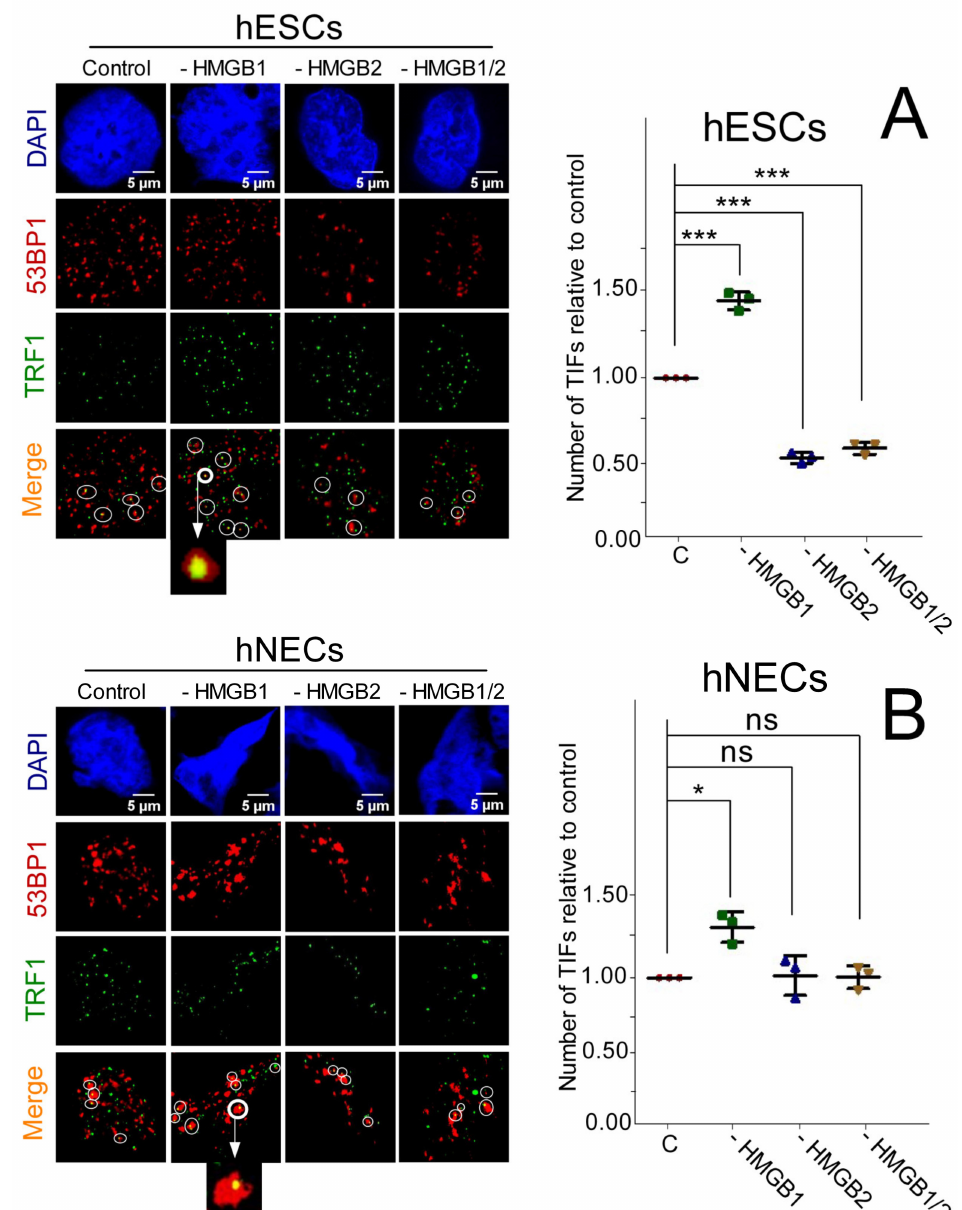
Figure 8. Accumulation of 53BP1 on telomeres in etoposide-treated cells with deregulated expression of HMGB1 / 2 . ( A ) hESCs or ( B ) hESC-derived neuroectodermal cells (hNECs) prepared according to Scenario A. Left panels: Following etoposide exposure (3.4 µ M / 3 h), control cells and HMGB1 - and / or HMGB2 -depleted cells were processed for immunofluorescence using antibodies against TRF1 (green) and 53BP1 (red) and staining of DNA (blue). Right panels: bar graphs indicate cells with ≥ 4 colocalization events of 53BP1 with telomeres (TRF1) as number of TIFs (Telomere Dysfunction-Induced Foci) relative to control cells per nucleus. The number of TIFs per nucleus in control cells was arbitrarily set as 1. In each of the cell lines, ~200 nuclei were analyzed using CellProfiler modular image analysis software (https: // cellprofiler.org). Colocalization of 53BP1 with telomeres is indicated by circles, and some colocalization events (enlarged) are circled. “C”, cells transfected with empty vector. Statistical di ff erences among samples were evaluated using one-way ANOVA analysis of variance followed by Tukey’s multiple comparison test; p -value < 0.05 was considered to indicate significance ( p > 0.05 = not significant, ns; * p < 0.05, and *** p < 0.001). Scale bar = 5 µ